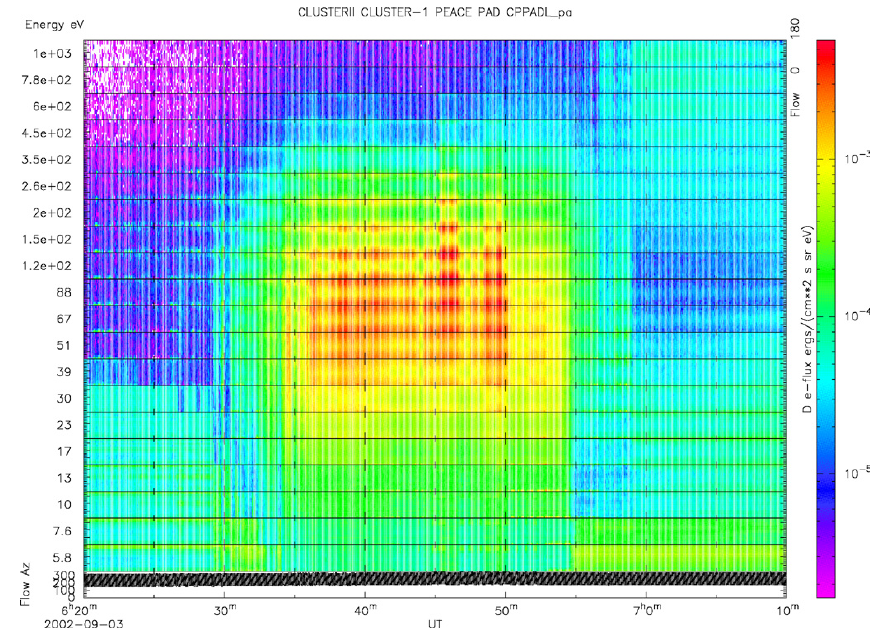
Fig. 6. PEACE-LEEA electron pitch angle-time spectrogram from SC1 showing, for each energy bin, the colour-coded energy flux.